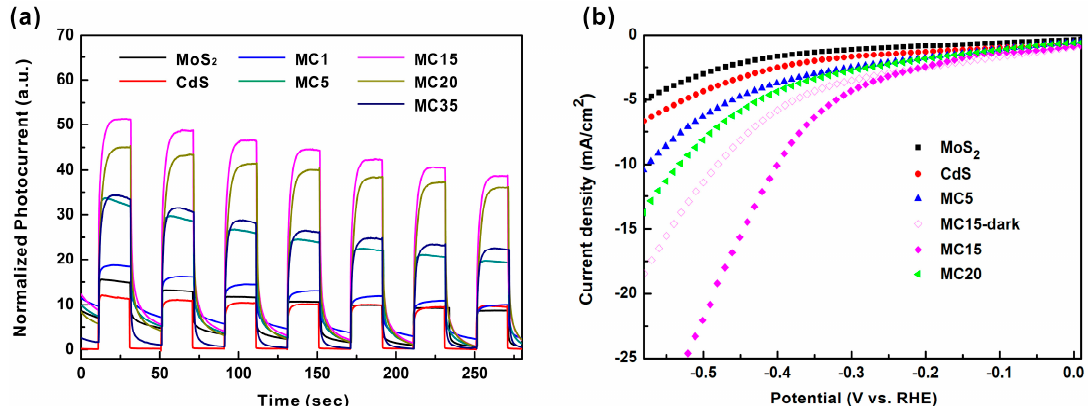
Figure 6. ( a ) Photocurrent responses of MoS 2 , CdS, and MoS 2 / CdS nanocomposites; ( b ) polarization curves of MoS 2 , CdS, MC5, MC15, and MC20.